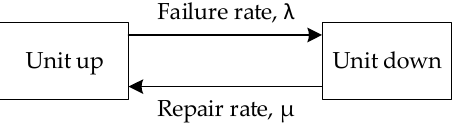
Figure 3. Two-state model for a generating unit.